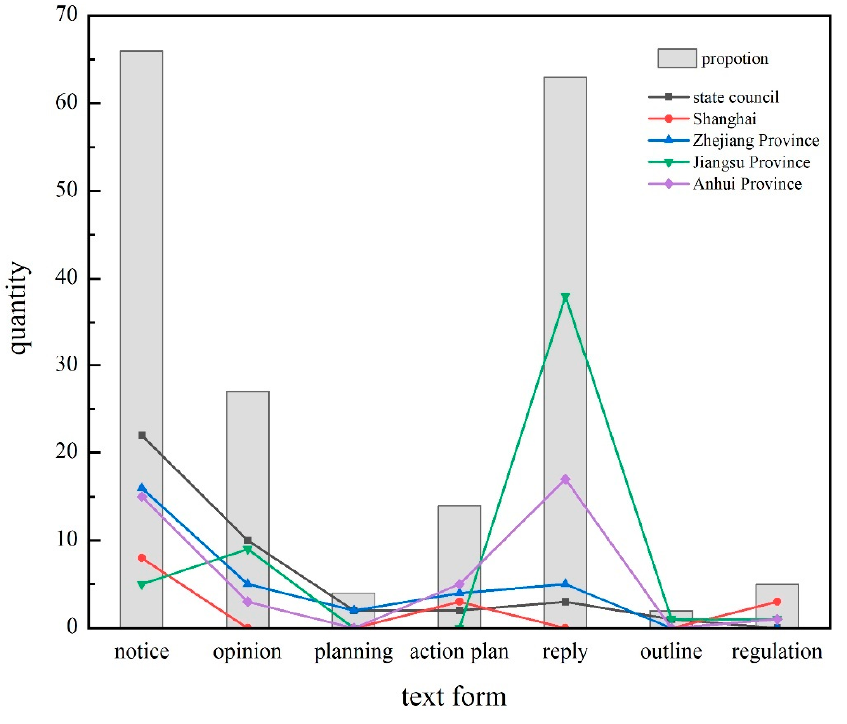
Figure 3. Statistics representing policy texts.